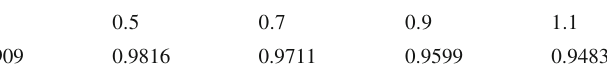
Table 1 Resonant oscillation frequencies of the composed stationary compact-reflecting-star–linearized-massive-scalar-field configurations with γ = 10 and l = 0. We present the smallestresonant oscillationfre- quency (cid:16) min (α) of the stationary bound-state massive scalar fields for variousvaluesofthedimensionlessstar–fieldmassparameter α ≡ M μ .